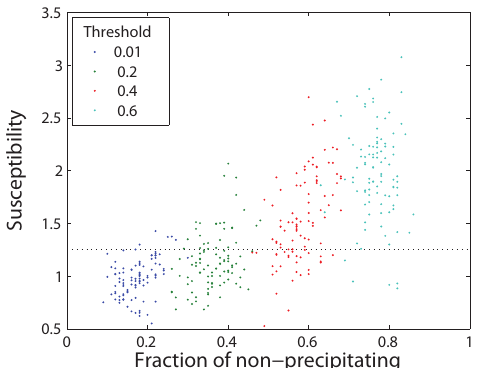
Fig. A5. Susceptibility estimates from TLD as a function of the number of non-precipitating points that went into calculating the susceptibility. Colors indicate different levels of the thresholds: 0.01 (blue), 0.2 (green), 0.4 (red), and 0.6 (cyan). The dotted line repre- sents the underlying β